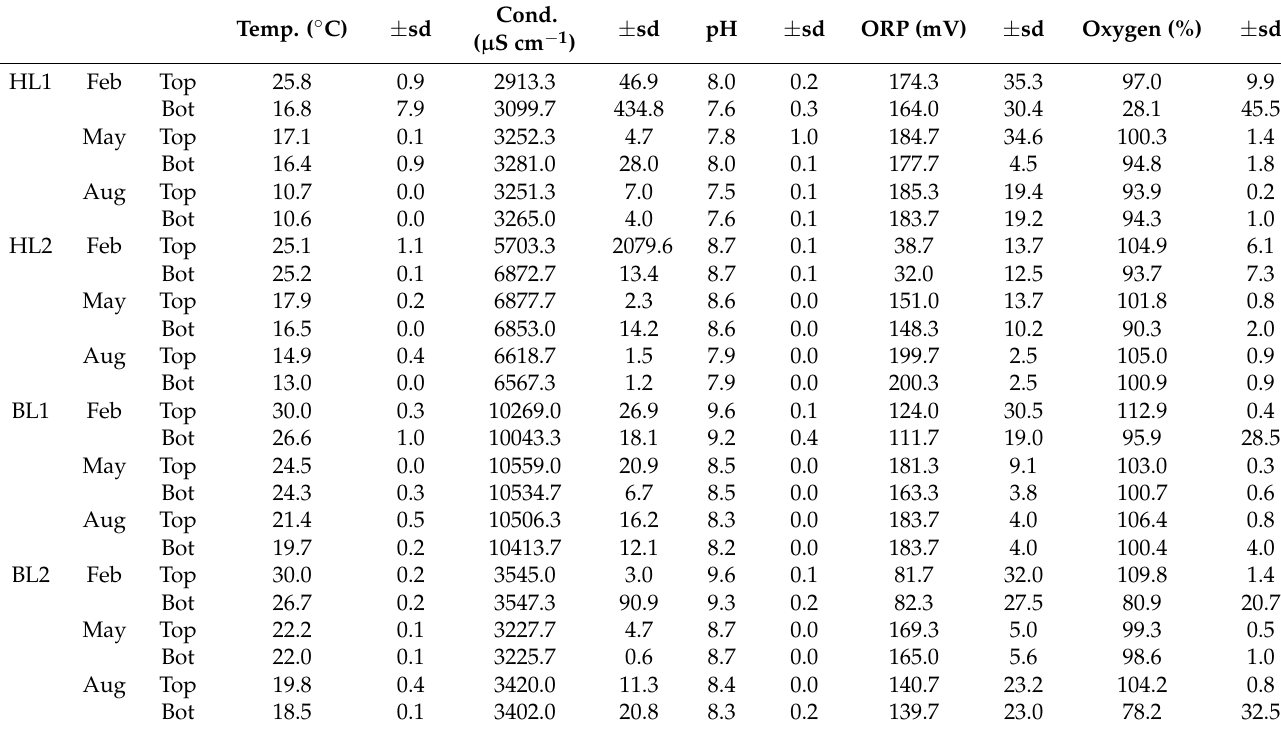
Table 1. In situ measurements collected from Australian mine pit lakes in the Bowen Basin, QLD (Bowen Lake 1; BL1, Bowen Lake 2; BL2) and the Hunter Valley NSW (Hunter Lake 1; HL1, Hunter Lake 2; HL2) in 2019. ‘Habitat’ was bottom (bot) or top of lake waters. n = 3 per